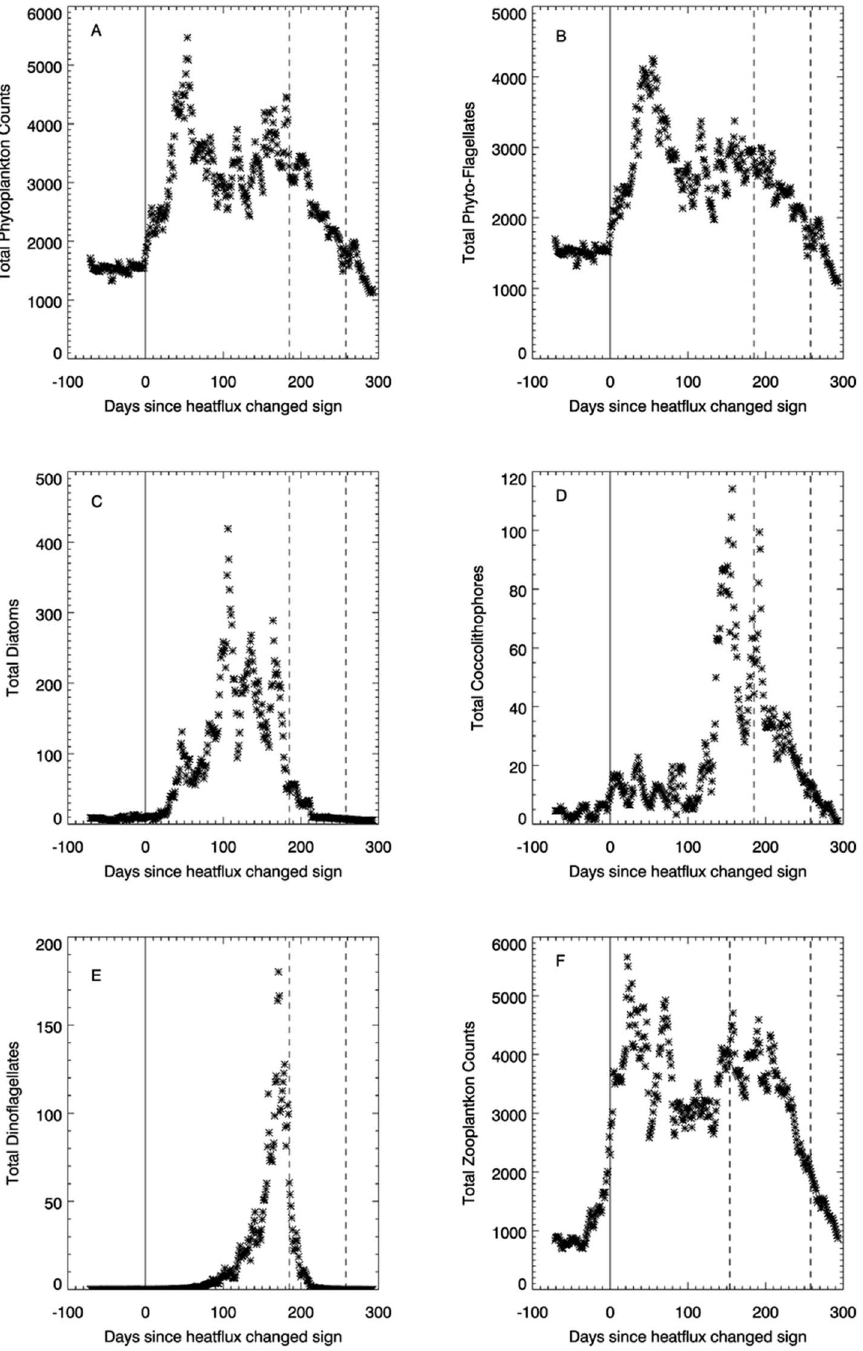
Figure 1. Entire time-normalized series at station L4 with a median filter applied to the phytoplankton ( 1992–2010 ) and zooplankton ( 1988–2010 ) abundance data ( units: cells mL 2 1 , individuals m 2 3 , respectively ) . Phytoplankton species are aggregated as (A) total; (B) phytoflagellates; (C) diatoms; (D) coccolithophores and (E) dinoflagellates. Zooplankton are aggregated as (F) total zooplankton. The solid line indicates day zero, where the NHF switches from negative to positive and remains positive for more than 7 days. The two dashed vertical lines shown in all the panels indicate the minimum and maximum number of days after the positive NHF switch that the NHF returns to being negative (for more than 7 days).